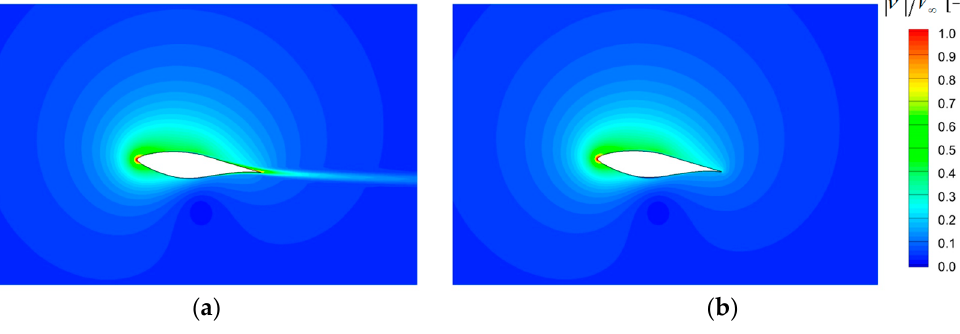
Figure 4. Contours of dimensionless-induced velocity: ( a ) Induced by the airfoil entity, ( b ) induced by the distributed vortices, 1 × 10 6